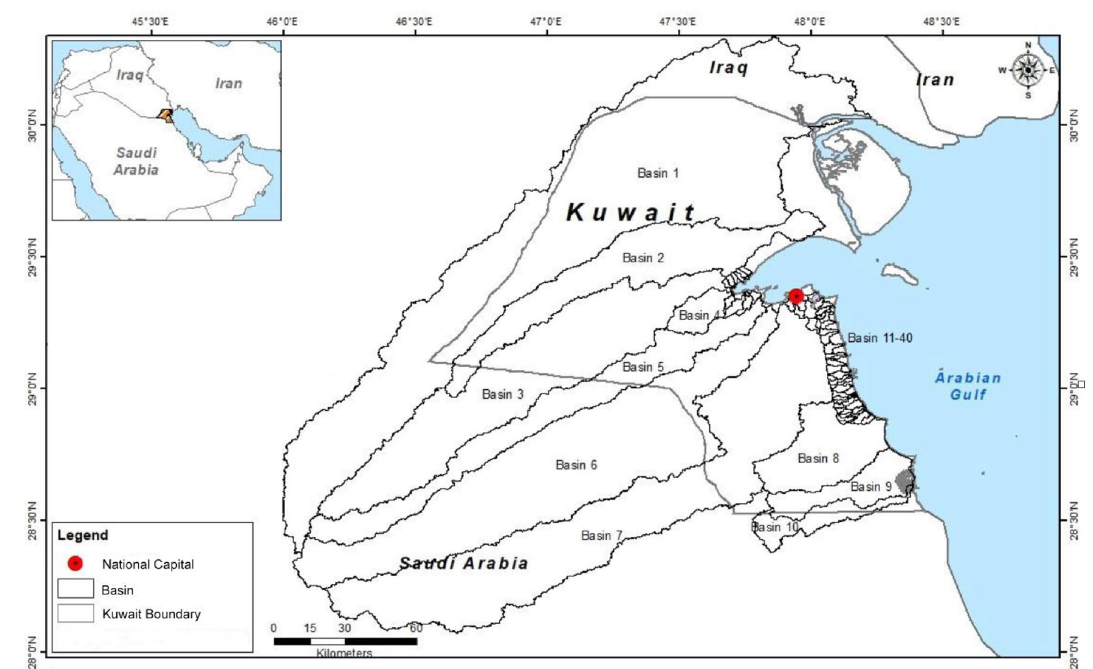
Fig. 2 Spatial distribution of the 40 water-runoff (river) basins in Kuwait. Source Kuwait Institute for Scientific Research (KISR)